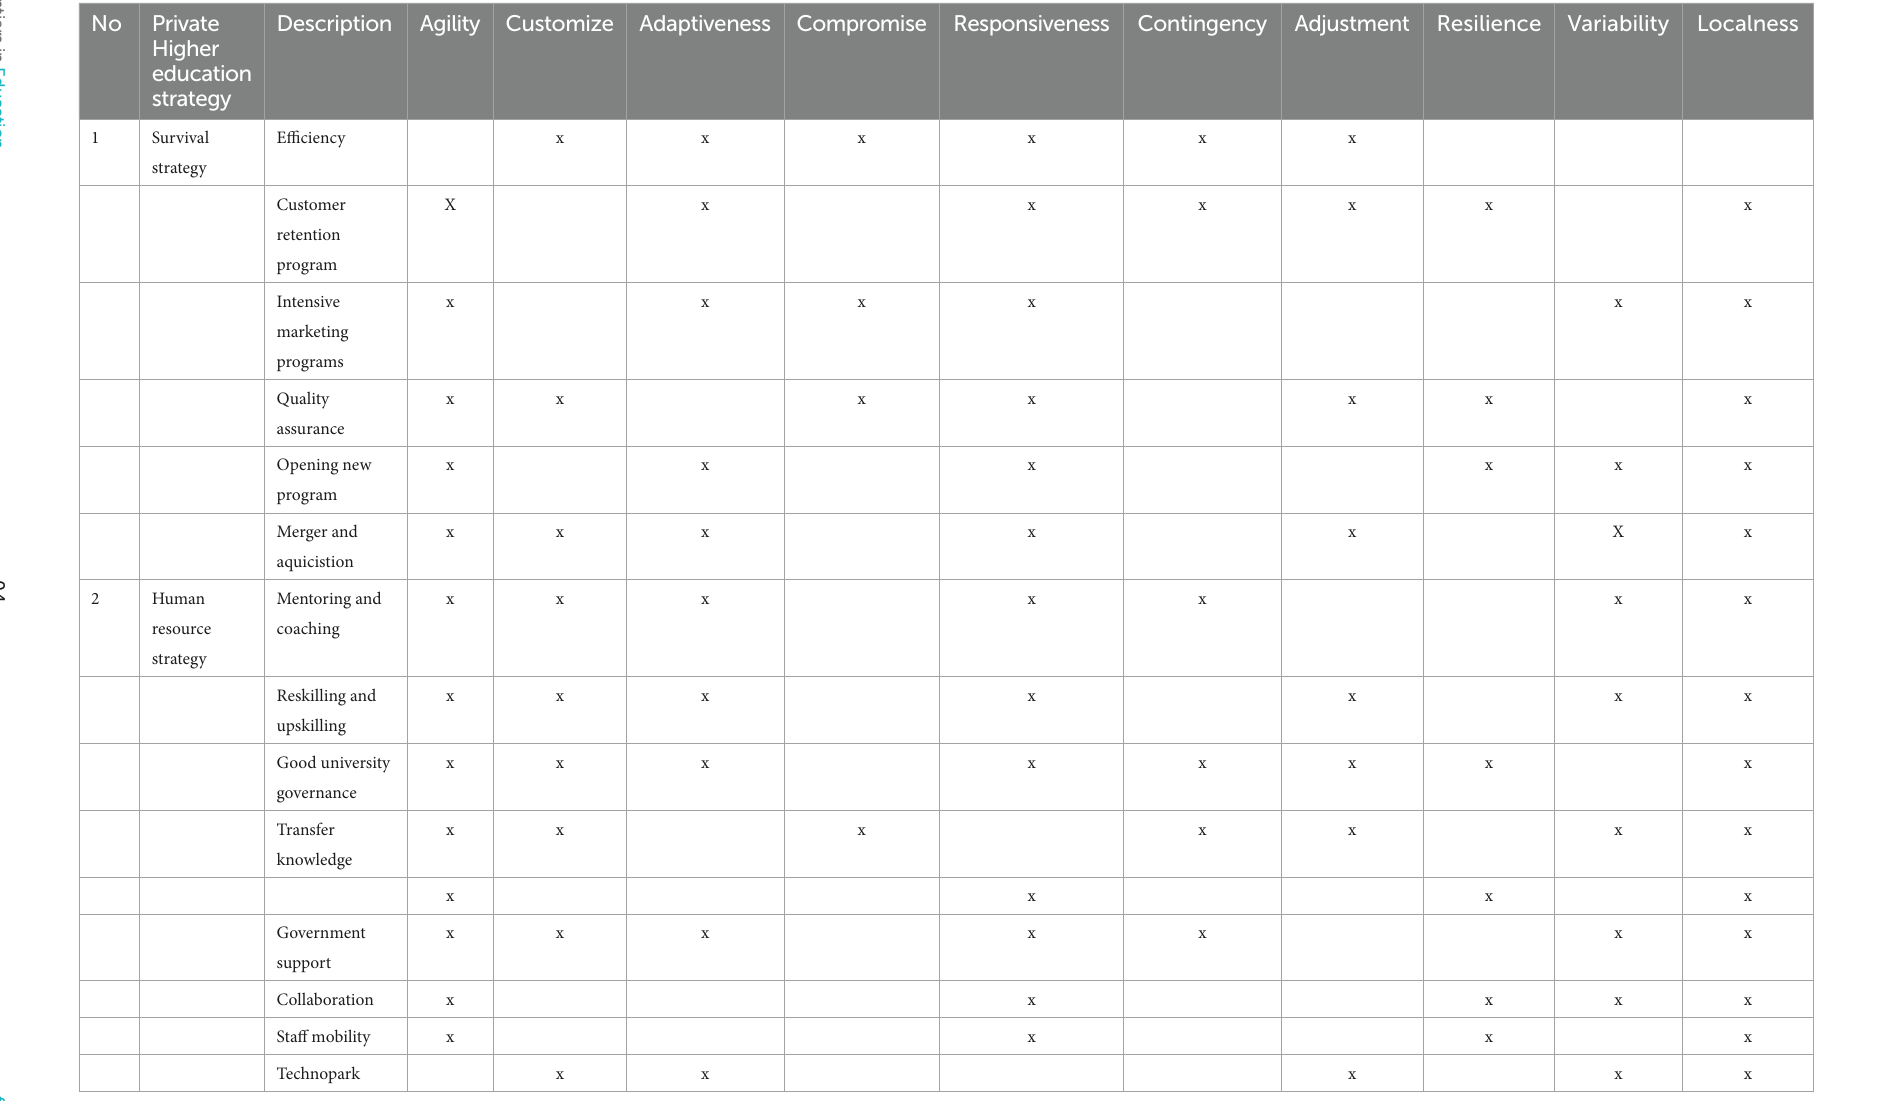
TABLE 2 Private higher education survival and human resource